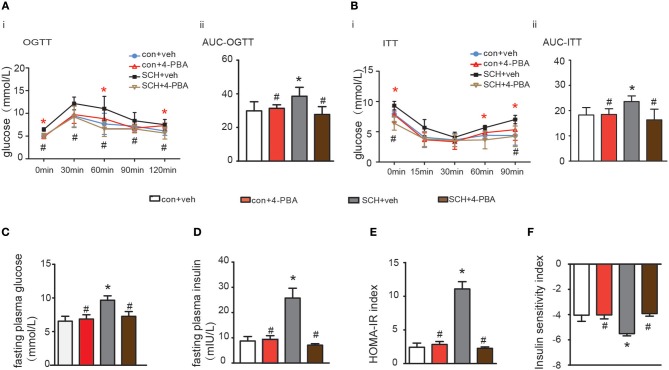
4-PBA alleviated abnormal glucose metabolism and IR in SCH mice. (A) Oral glucose tolerance test (OGTT) was implemented to detect glucose tolerance at the 17th week of administering MMI to mice in the drinking water (n = 4–6). (B) Insulin tolerance test (ITT) was implemented to assess insulin-stimulated glucose disposal at the 18th week of administering MMI to mice in the drinking water (n = 4–6). (C) The fasting plasma glucose level was assayed at the 18th week (n = 3–4). (D) The fasting plasma insulin level was assayed at the 18th week (n = 3–4). (E) Homeostasis Model Assessment-Insulin Resistance (HOMA-IR) index was calculated. (F) Insulin sensitivity index (ISI) was calculated. The data are presented as the mean ± SD. *p < 0.05 compared with vehicle treated mice group. #p < 0.05 compared with 4-PBA treated SCH mice group.